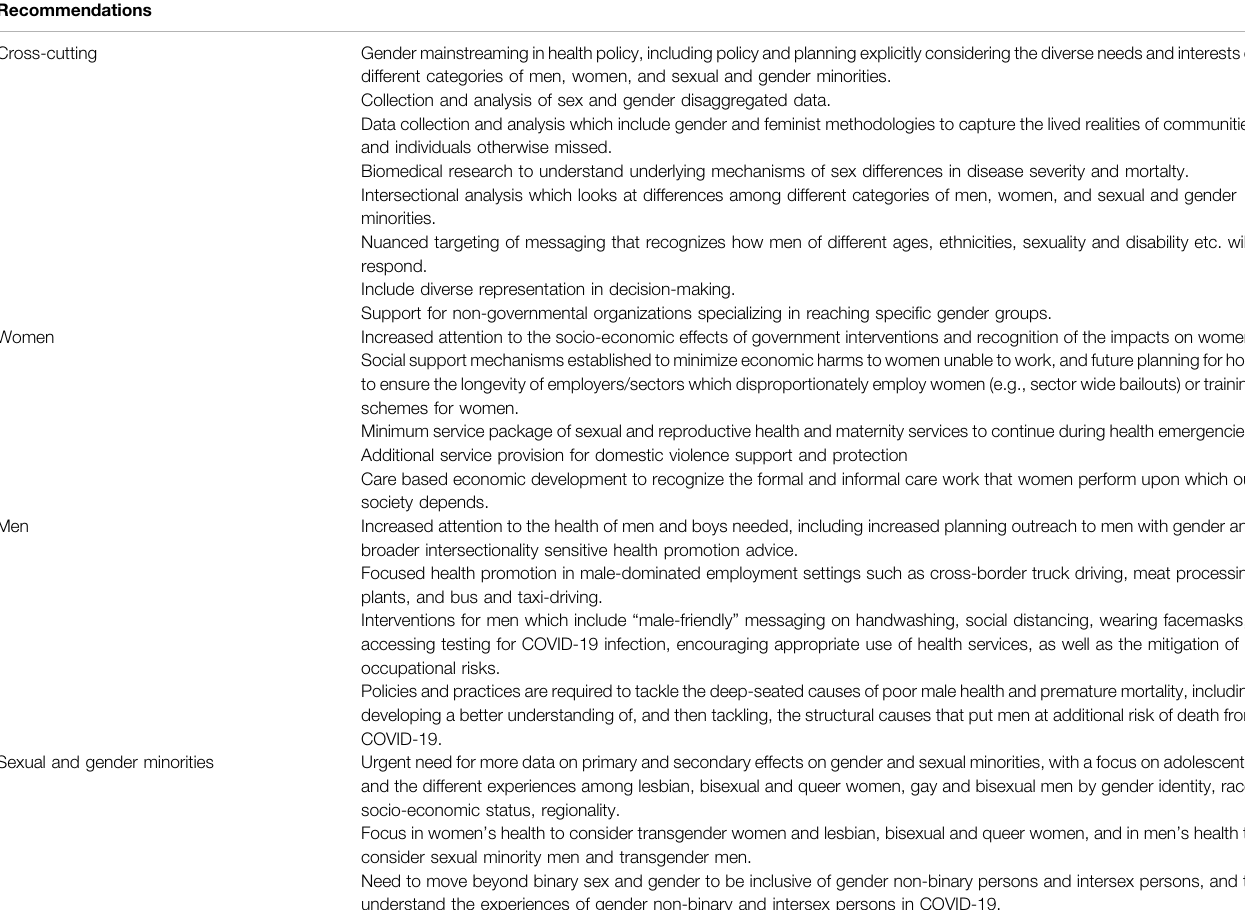
TABLE 2 | Recommendations for addressing gendered impacts of